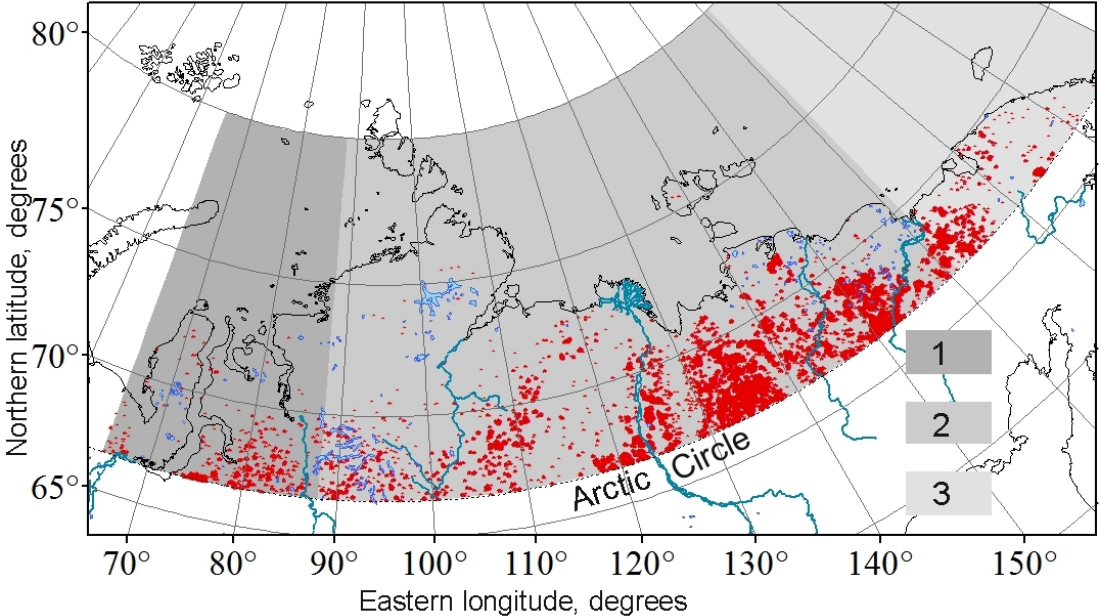
Figure 1. Geographic sectors of the Siberian Arctic: (1) Western Siberia (from the Ural Mountains eastward to the Yenisei River), (2) Eastern Siberia (eastward from the Yenisei River to the Kolyma River), (3) Far East (eastward from the Kolyma River to the easternmost. The locations of wildfires during the 2001–2021 period are marked by red.